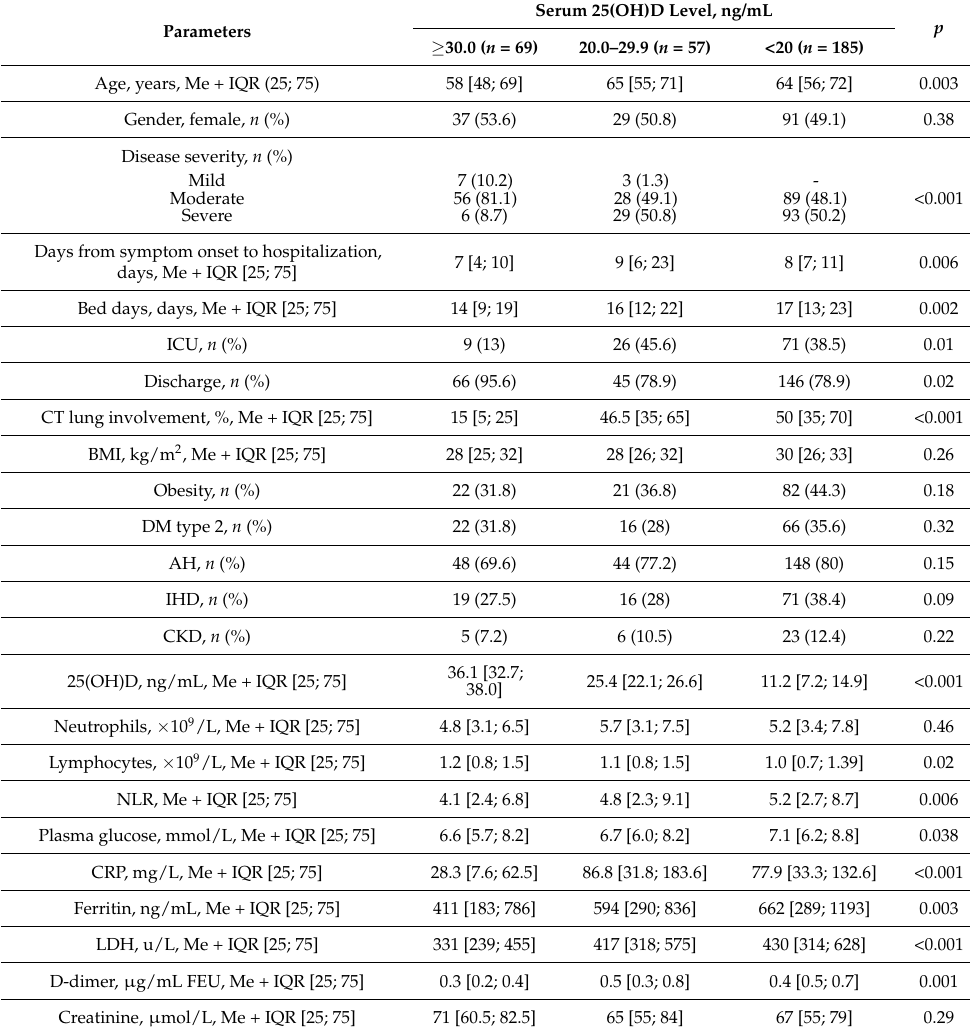
Table 3. Patients’ baseline characteristics depending on serum 25(OH)D